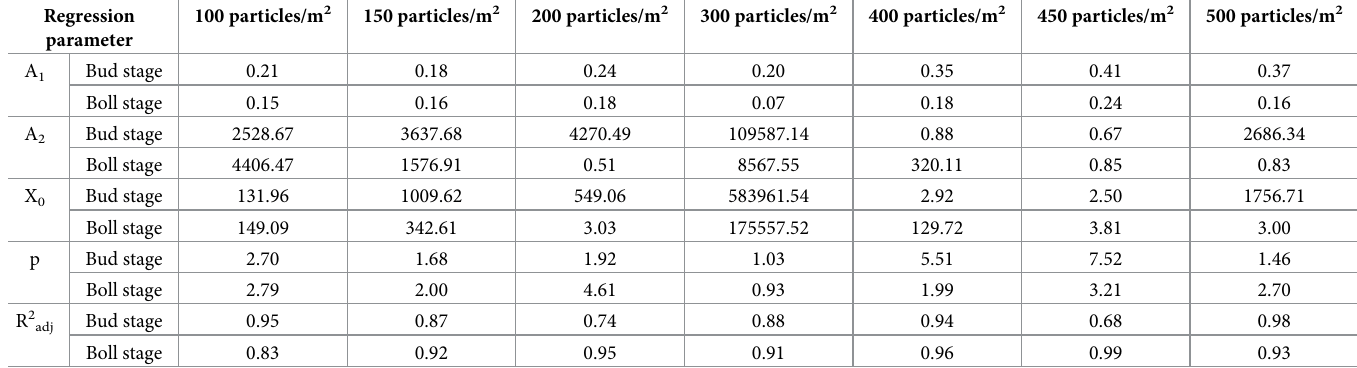
Table 2. Regression parameters of the logistic functions between the defoliation rate and hail size. Regression parameter